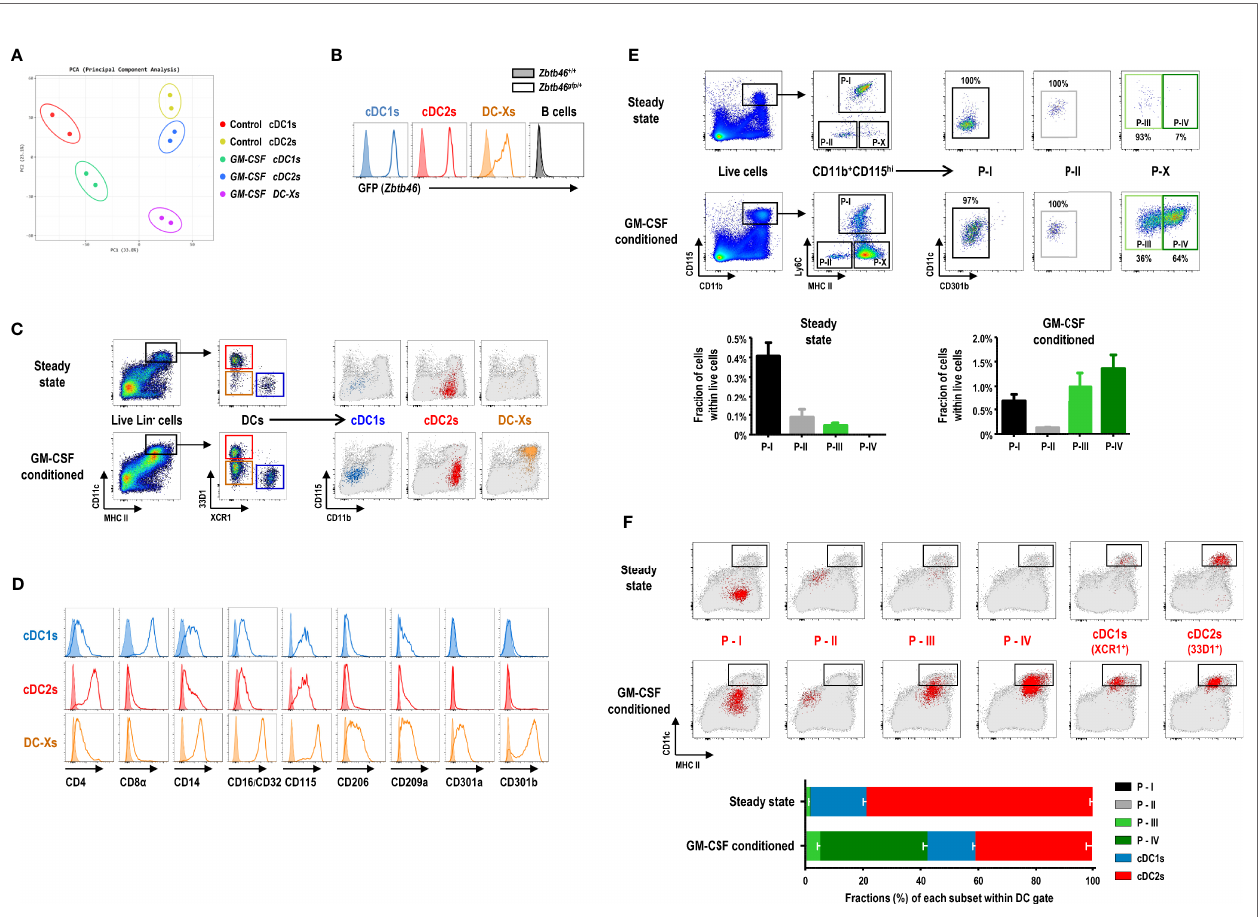
FIGURE 3 | GM-CSF-induced splenic DCs express high levels of CD115. (A) Principal components analysis (PCA) of transcriptomes of splenic DC subsets in steady-state (control) and GM-CSF-treated mice (n = 2 mice for each cell population). (B) Flow cytograms showing GFP levels, as a reporter for Zbtb46 gene expression, in splenic DC subsets and CD19 + B cells by comparing between Zbtb46 gfp/+ (line histograms) and Zbtb46 +/+ (shaded histograms) mice treated with GM-CSF. Representative fl ow cytograms (n = 3 mice for each genotype). (C) Gating strategy for each population of splenic DC subsets in control and GM-CSF-treated mice, backgated in a CD11b versus CD115 dot plot of total live-gated cells (gray dots). cDC1s represented by blue dots; cDC2s by red dots; DC-Xs by orange dots. Representative fl ow cytograms (n = 100 or more mice for each condition). (D) Flow cytograms showing the expression of the respective molecules (line histograms) on the surface of splenic DC subsets in GM-CSF-treated mice. Shaded histograms represent fl uorescence minus one (FMO) control samples. Representative fl ow cytograms (n = 2 mice for each condition). (E) Gating strategy (upper panels) identifying GM-CSF-induced DC population in the spleen. Fractions (lower graphs) of 4 splenic CD11b + CD115 hi cell populations, i.e., P-I, P-II, P-III, and P-IV in control and GM-CSF-treated mice. Data are shown in mean ± SEM (n = 3 mice for each condition). (F) Each population (red dots) of splenic DC and CD11b + CD115 hi cell subsets in control and GM-CSF-treated mice is backgated in an MHC II versus CD11c dot plot of total live-gated cells (gray dots). Fraction (lower graph) of each cell subset within the DC gate on fl ow cytograms (upper panels). Data are shown in mean ± SEM (n = 3 mice for each